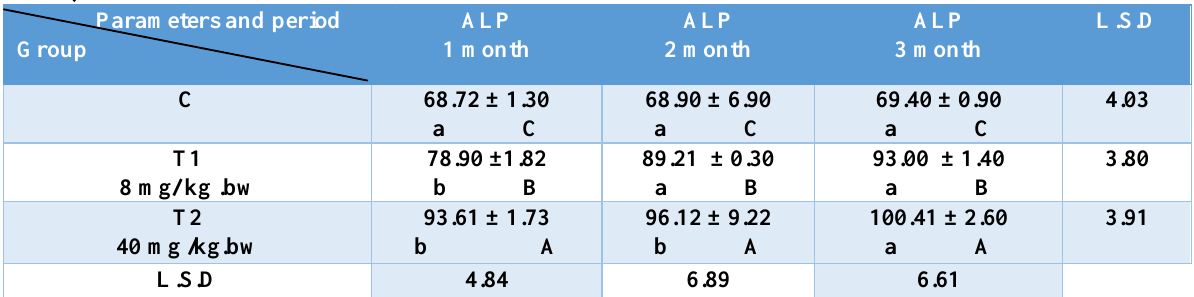
Different small letters means significant (P<0.05) results between months Different big letters means significant (P<0.05) results between groups. Table, 11: Values of ALP (U/ L) in serum of rats treated with different doses of